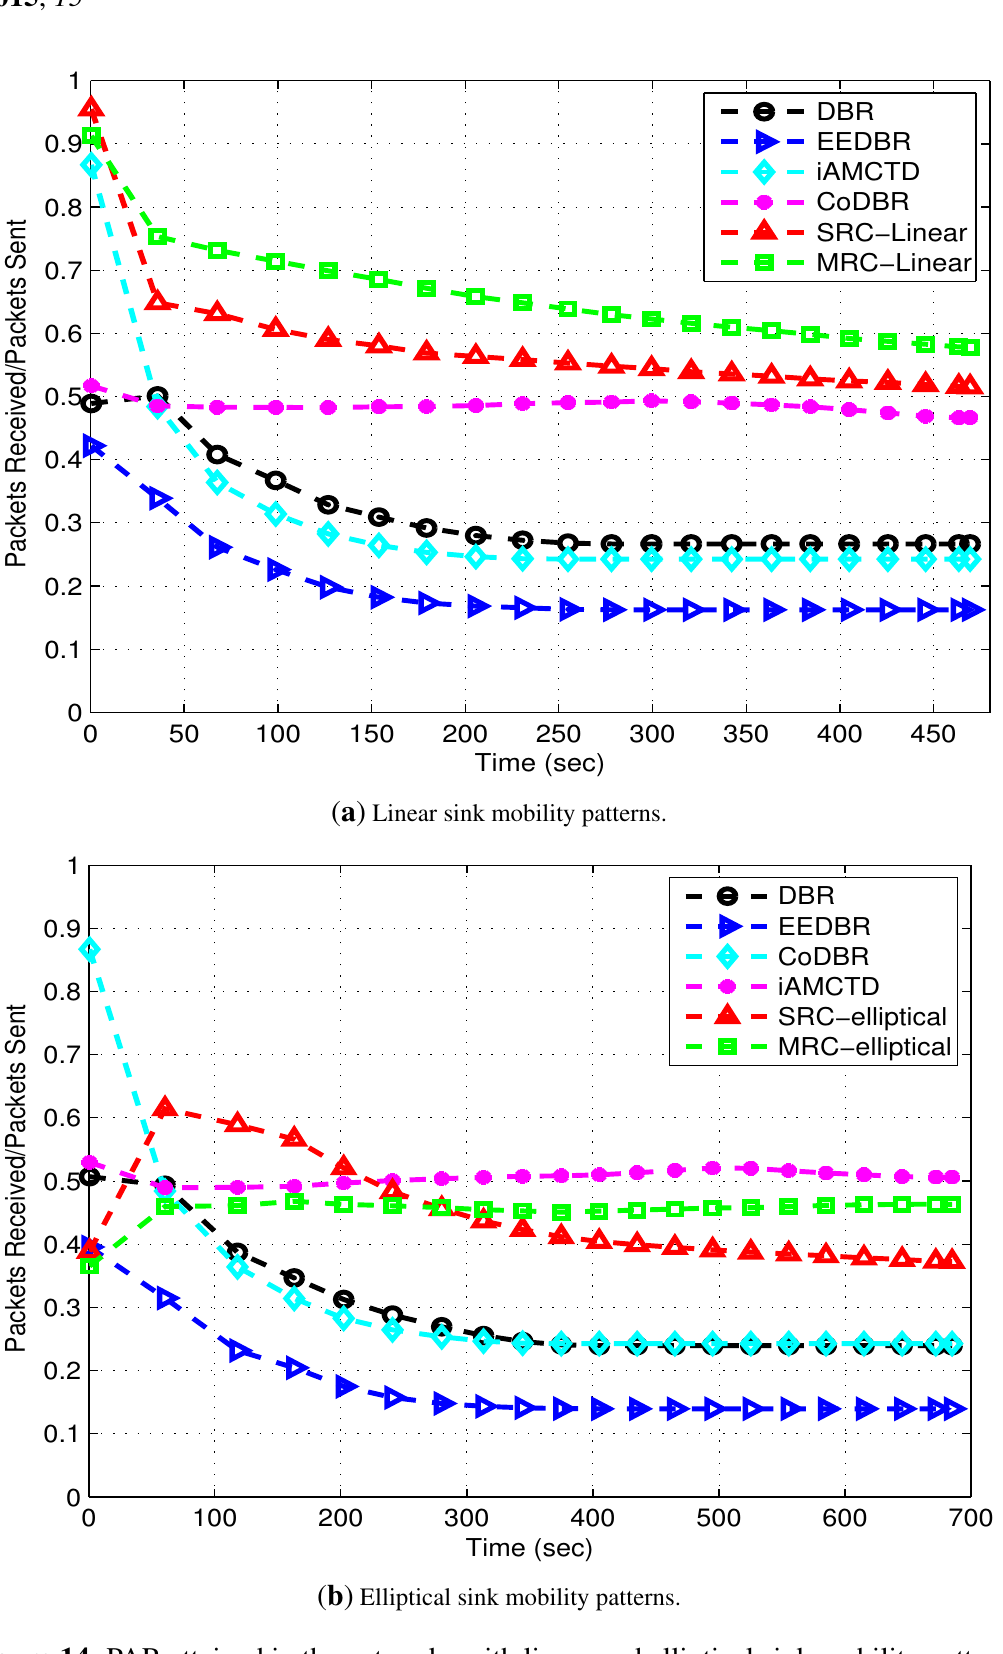
Zero indicates that both protocols have same value for that specific evaluation metric. Negative value indicates reduced value of a particular metric with respect to